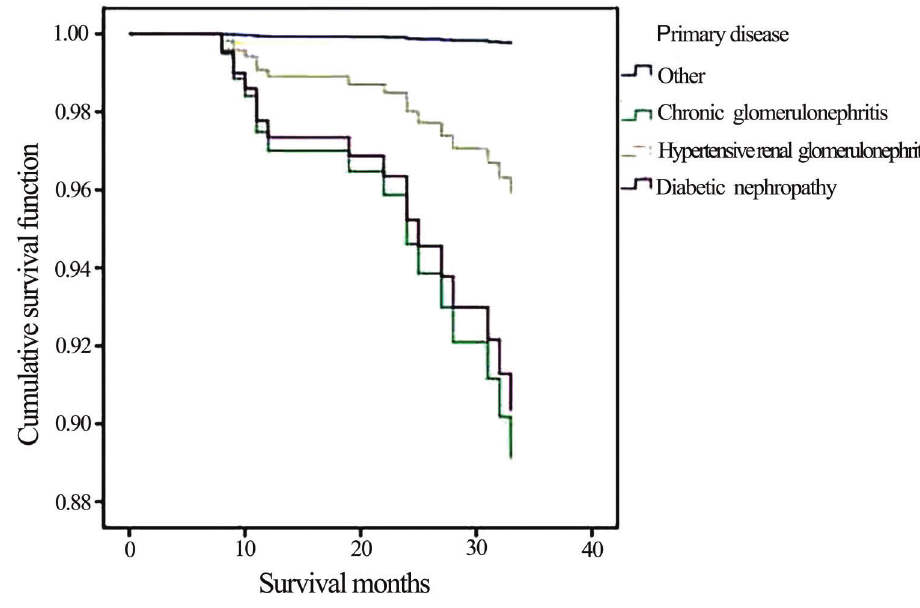
Figure 1. Comparison of survival curves of urgent-start peritoneal dialysis patients with different primary